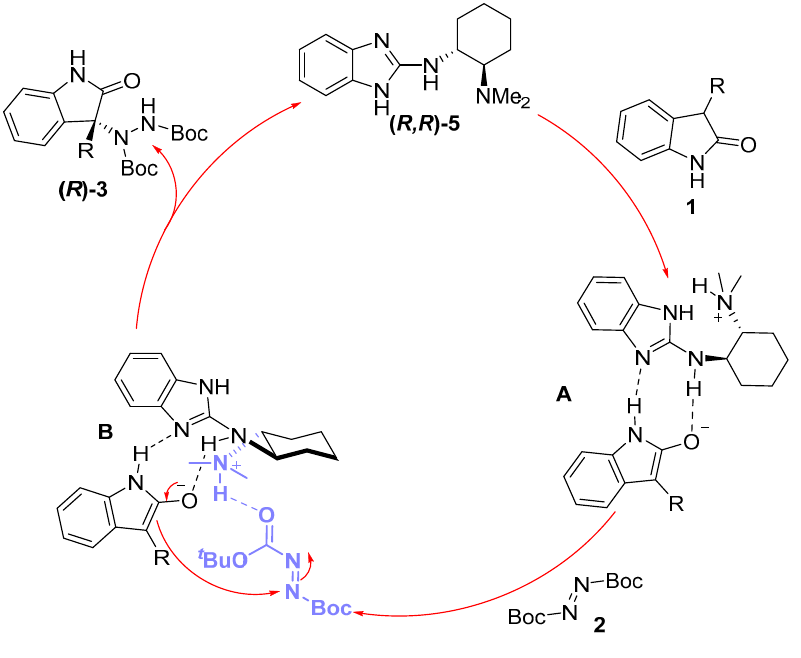
Figure 3. Proposed reaction mechanism.